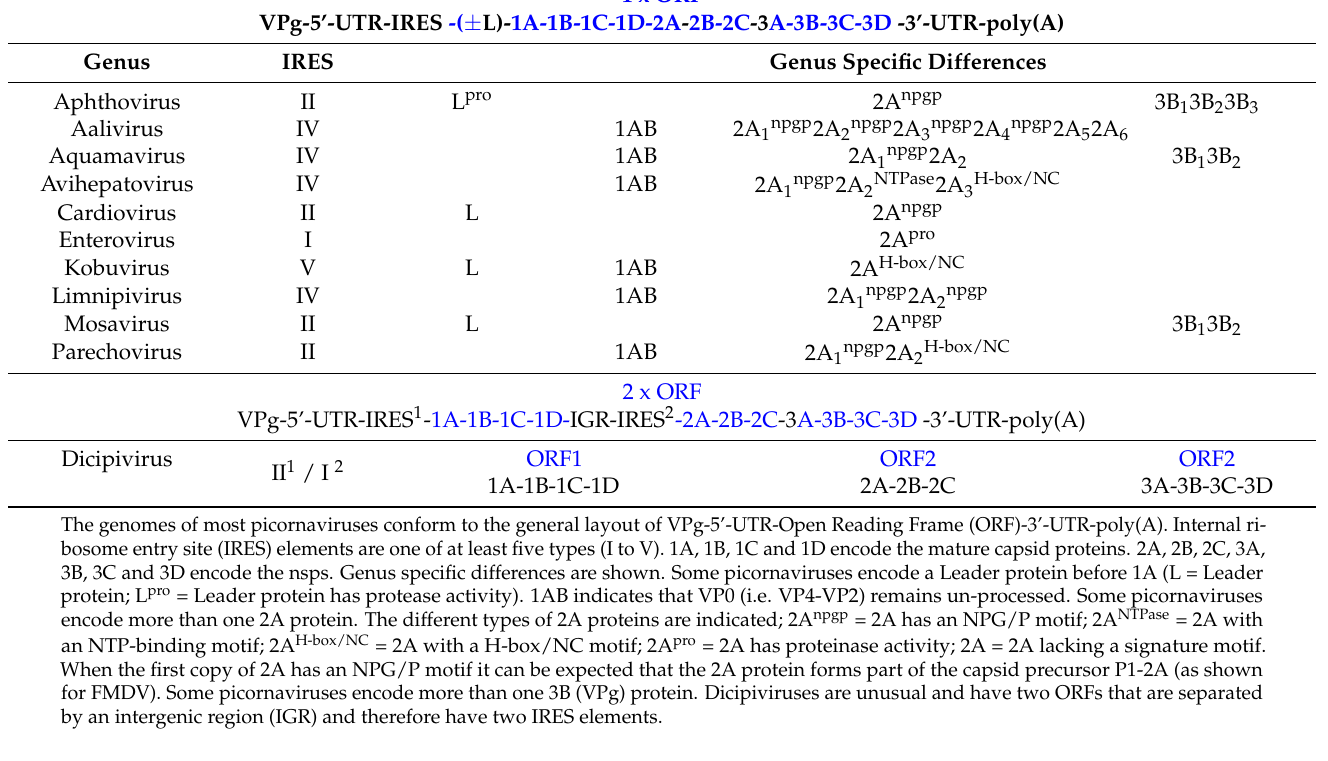
Table 1. Genome organization and genus specific differences of selected picornaviruses. Picornavirus General Genome Organization: 1 x